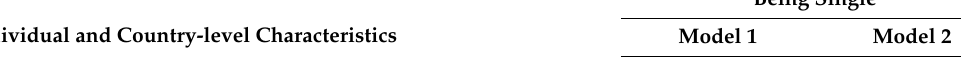
Table 2. Associations of individual and country-level characteristics with partnership status: results from unadjusted and adjusted multilevel logistic regressions showing odds ratios (OR) and 95% confidence intervals (95% CI) for being single.